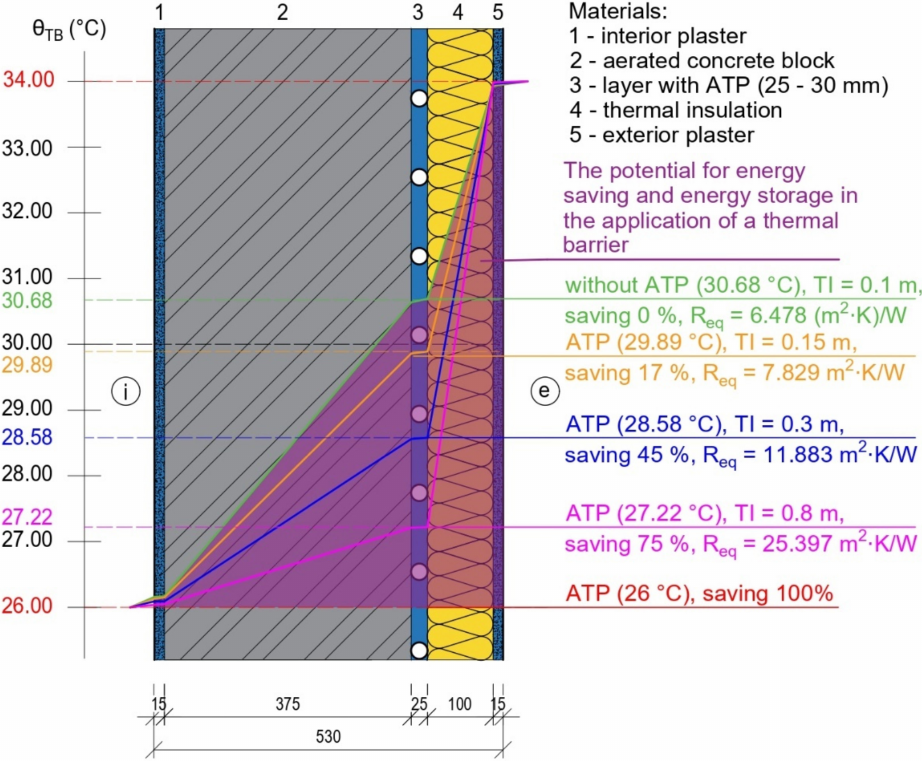
Figure 19. Mathematical-physical model of construction with isotherms for